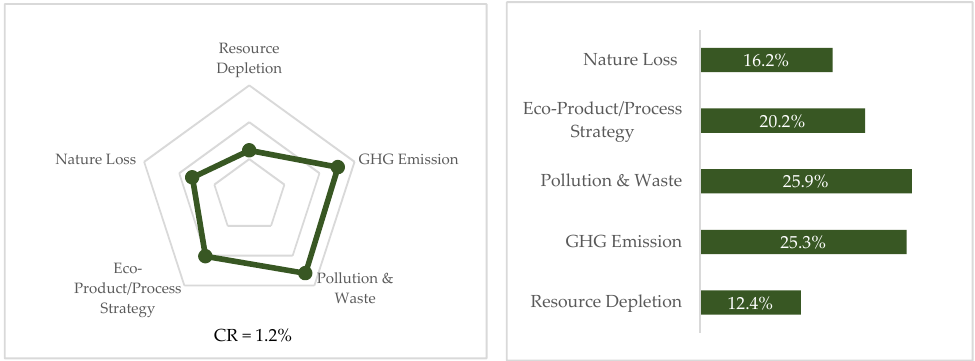
Figure 4. Local weights for E, environmental factors.